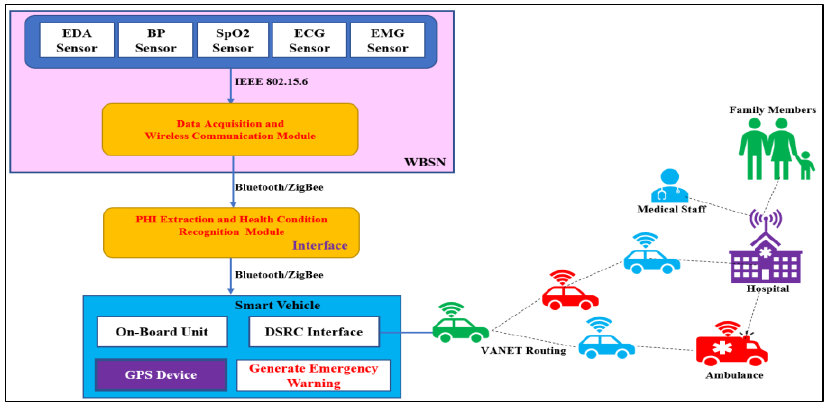
Figure 1. VANET health monitoring